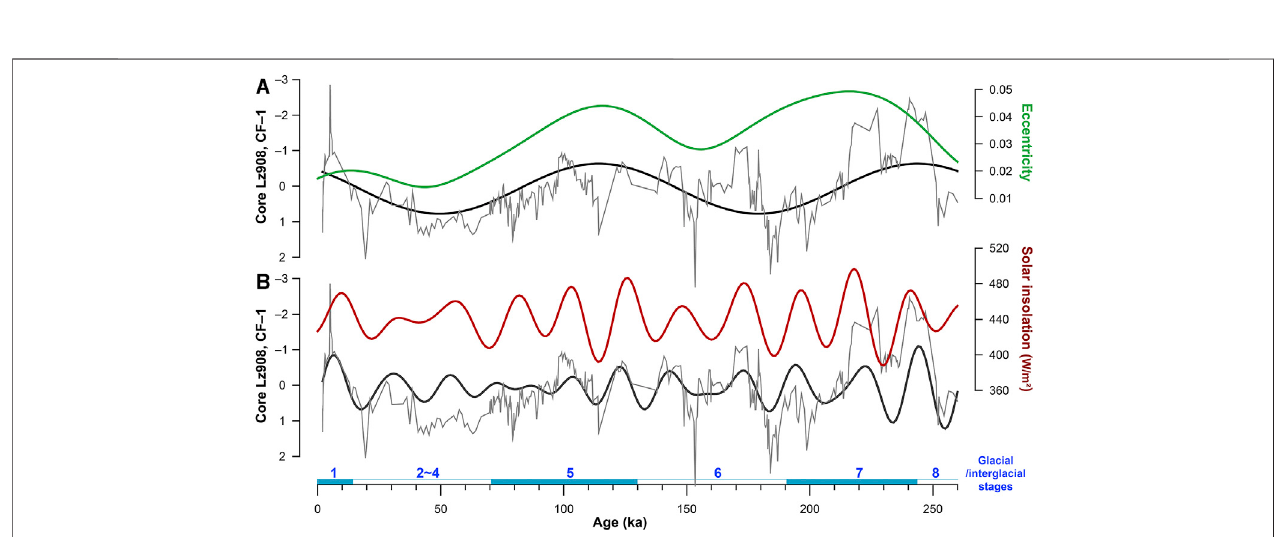
FIGURE 4| (A) Changes in color (CF – 1) index ofcore Lz908 (thin line) with low – frequentpassed variabilities (bold line; FFT fi lter, < 1/0.0125), versus Earth ’ sorbital eccentricity (Berger and Loutre, 1991); (B) Changes in color index of core Lz908 (thin line) with precession – band passed variabilities (bold line; FFT fi lter, 1/0.0255 ∼ 1/ 0.0235), versus changes in summer (July 21st) solar insolation at 65 ° N (Berger and Loutre, 1991).